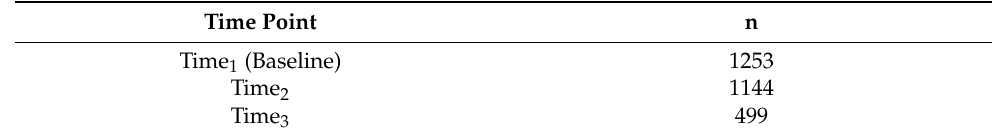
Table excludes participants with missing exposure or outcome data, which is why the sample size for the original data is smaller than the sample size of the imputed data. Table A8. Number of participants at each time